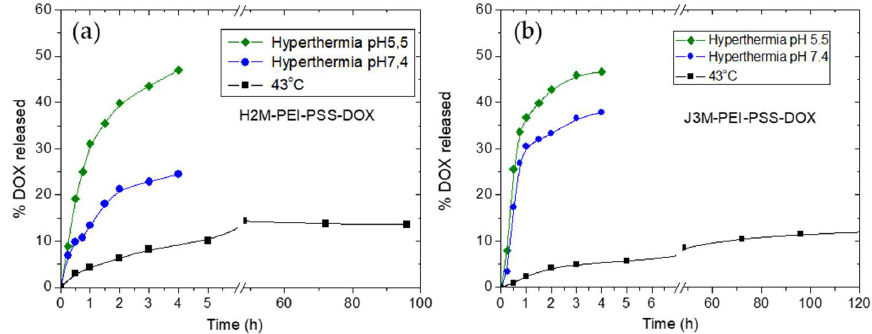
Figure 6. DOX release at 43 °C without the application of AC field (squares) ( a ), under AC field ( b ) at pH 7.4 (circles), and under AC field at pH 5.5 (diamonds), from both coated magnetic nanorods.